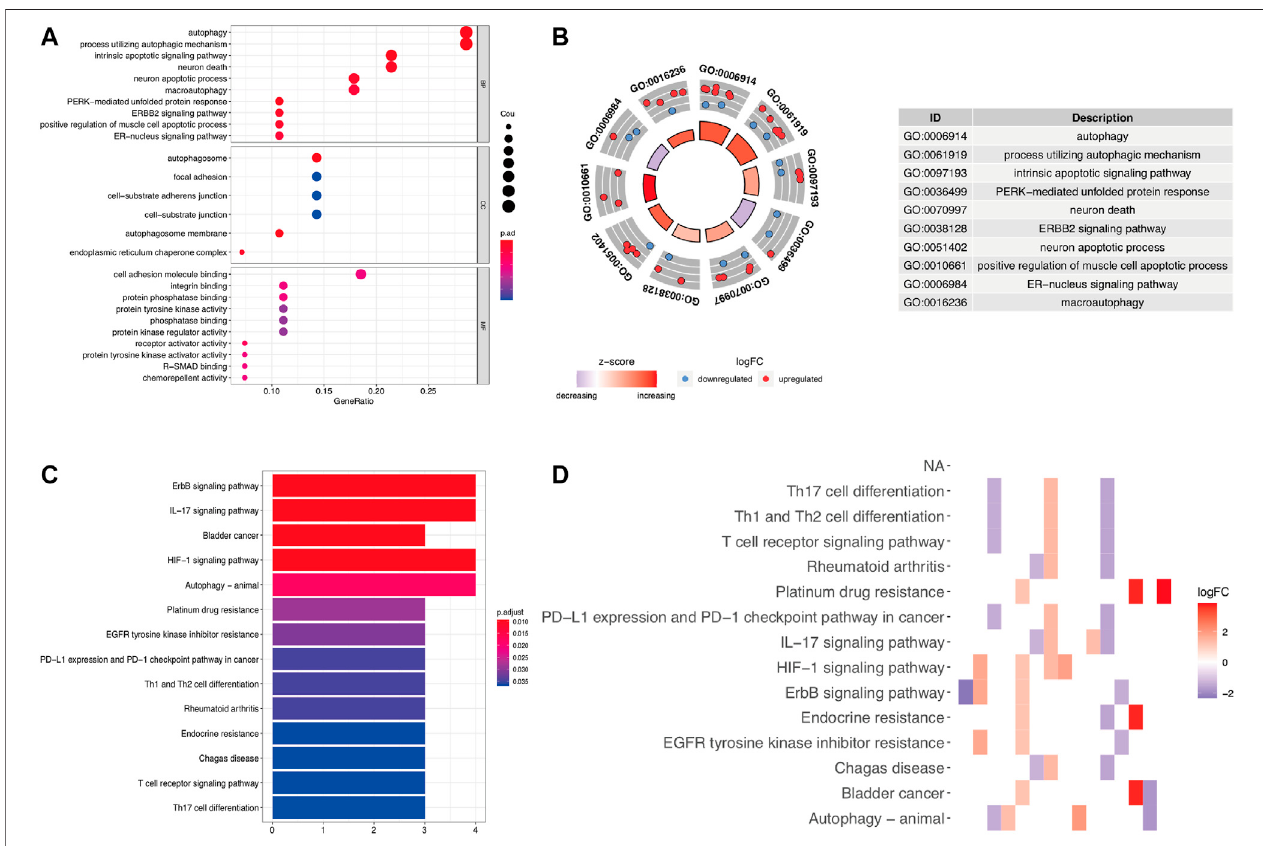
FIGURE 3 | Functional enrichment analysis of differentially expressed ARGs. (A,B) The bubble plot and circle plot of signi fi cant GO terms. (C,D) The bar plot and heat map of enriched KEGG pathways. GO, Gene Ontology; KEGG, Kyoto Encyclopedia of Genes and Genomes.